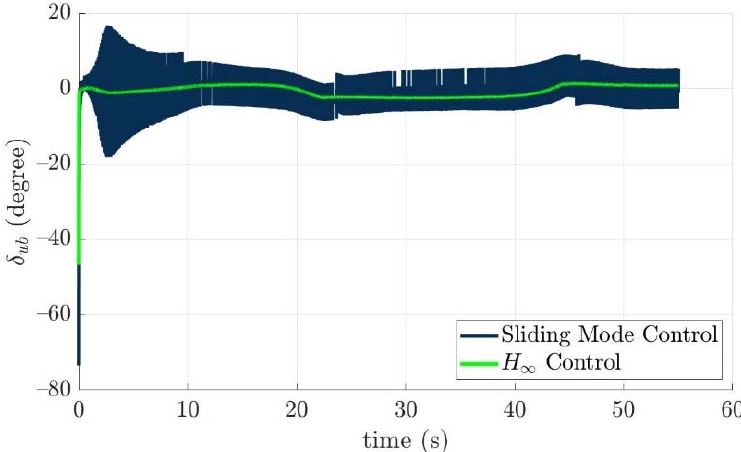
Figure 27. The upward bow rudder angles of the controlled torpedo-like underwater vehicle for two control laws, respectively.